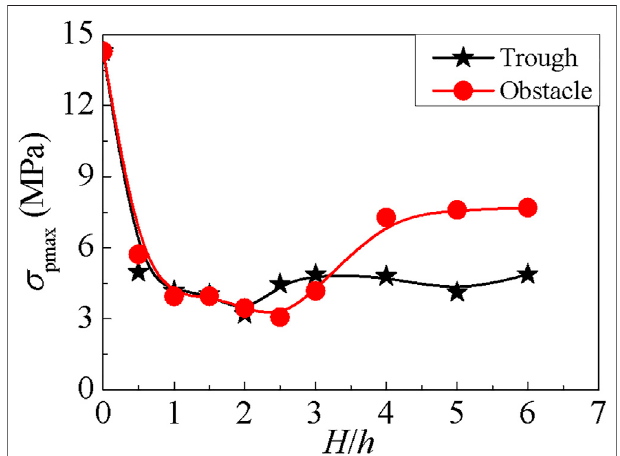
FIGURE 9 | The maximum stress of the abalone foot in the trough or behindtheobstaclewithvariousvaluesof H / h ,wheretheredcurverepresents obstacle and the black curve represents